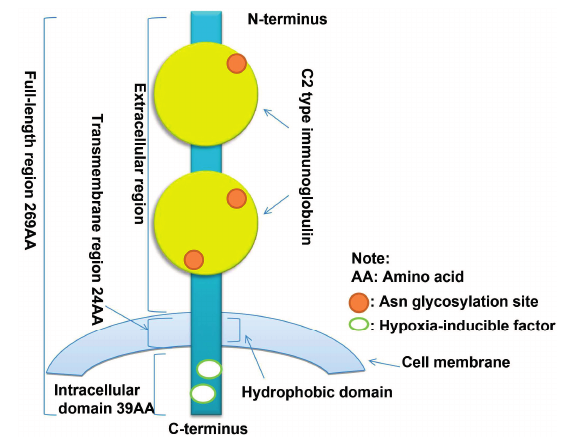
Figure 1. The molecular structure of